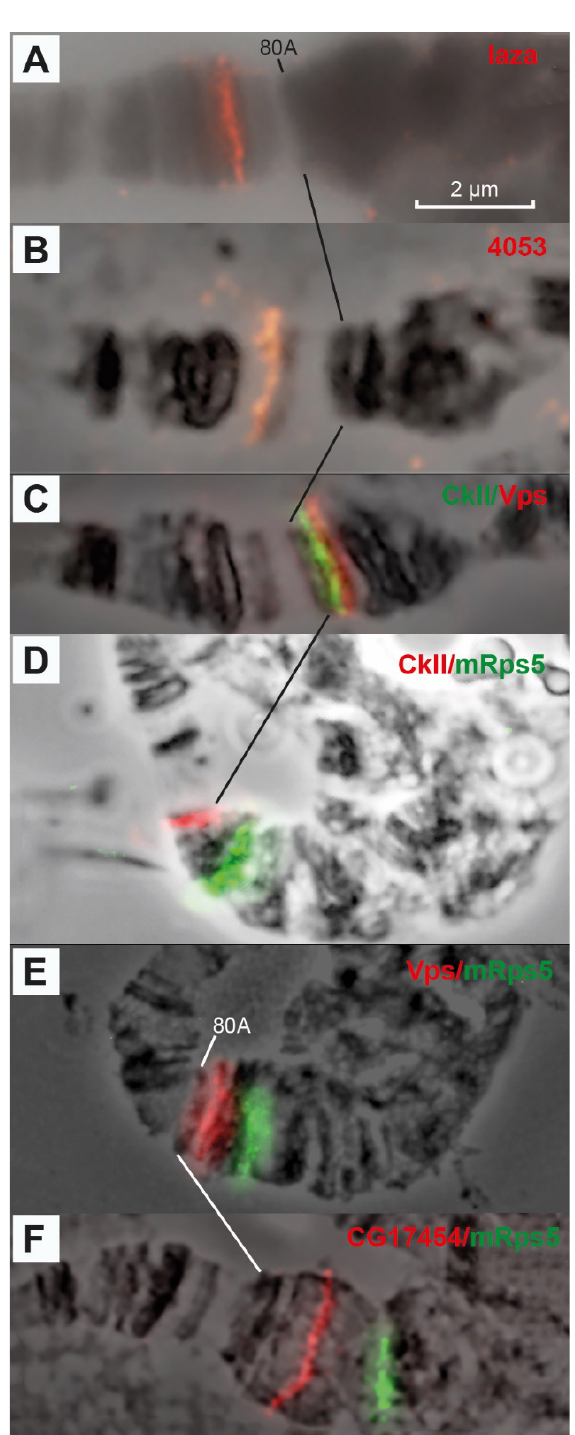
Figure 7. Localization of probes on chromosome 3 heterochromatin: laza (79D1-4 ( A )), 4053 (79E8-78F1-2 ( B )), CkII/Vps (80A3/80B3 ( C )), CkII/mRsp5 (80B3 and 80F ( D )), Vps/mRsp5 (80B3 and 80F ( E )), CG17454/mRsp5 (80D and 80F ( F )). The genotype in all figure parts is Rif1 1 ; SuUR ES Su(var)3-9 06 . Scale bar value is the same for every figure.